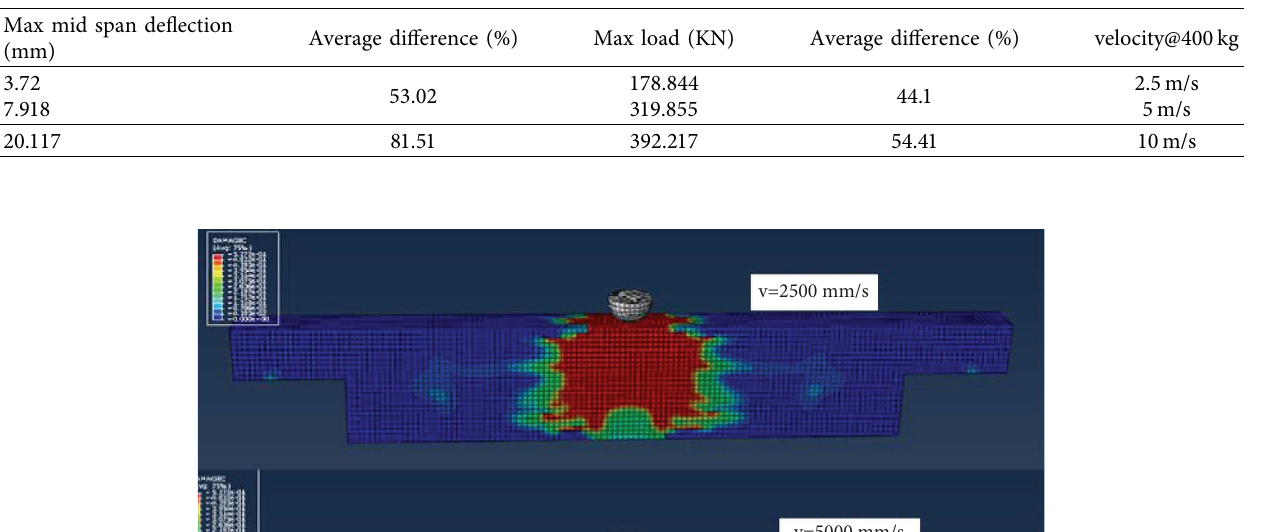
Table 6: Load vs defection analysis result at diferent velocity.